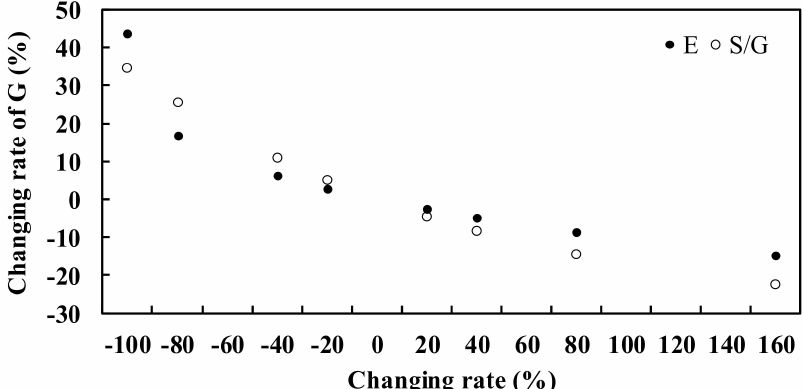
Figure 7. Changing rates of global solar irradiance (%) caused by the changes in one factor (%), while other factors are kept at their original levels for S/G < 0.80.